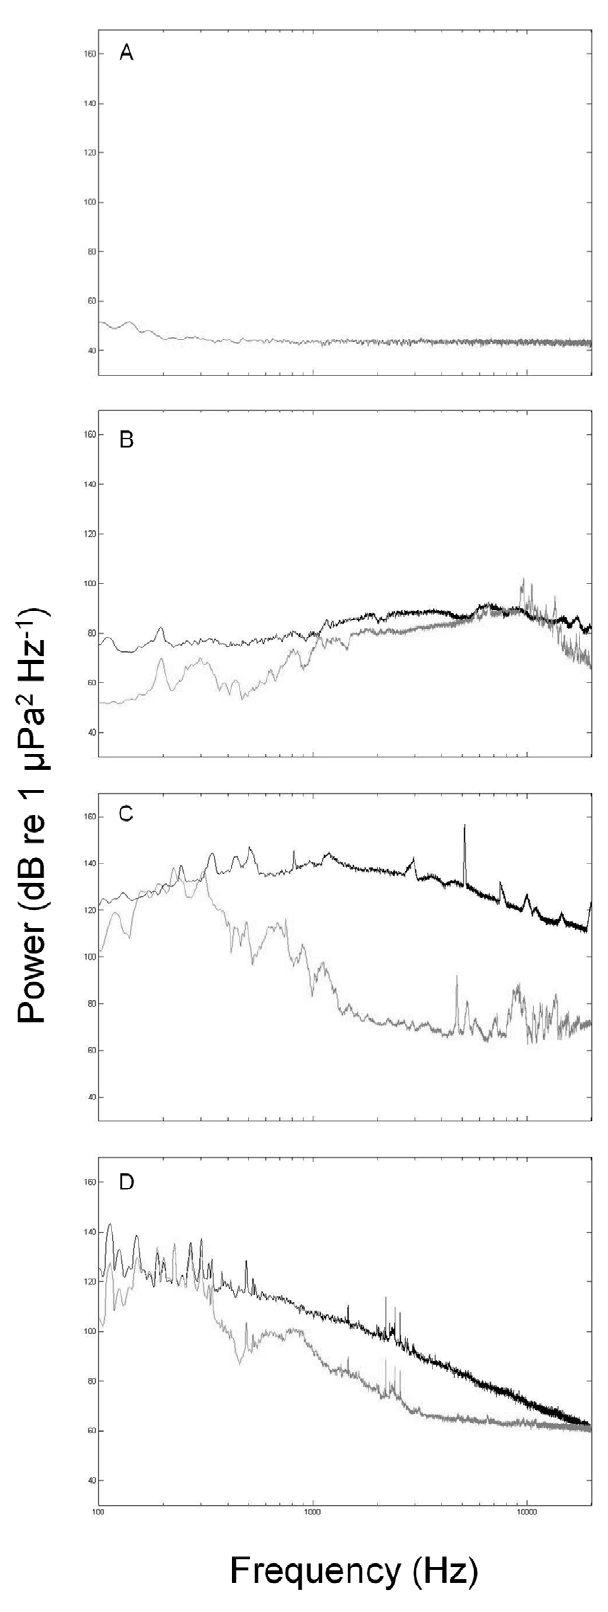
Figure 1. Spectral composition of experimental sound sources and when played back in experimental tanks. A) Sound recorded in silent treatment tanks (control); B) Mudflat recording from